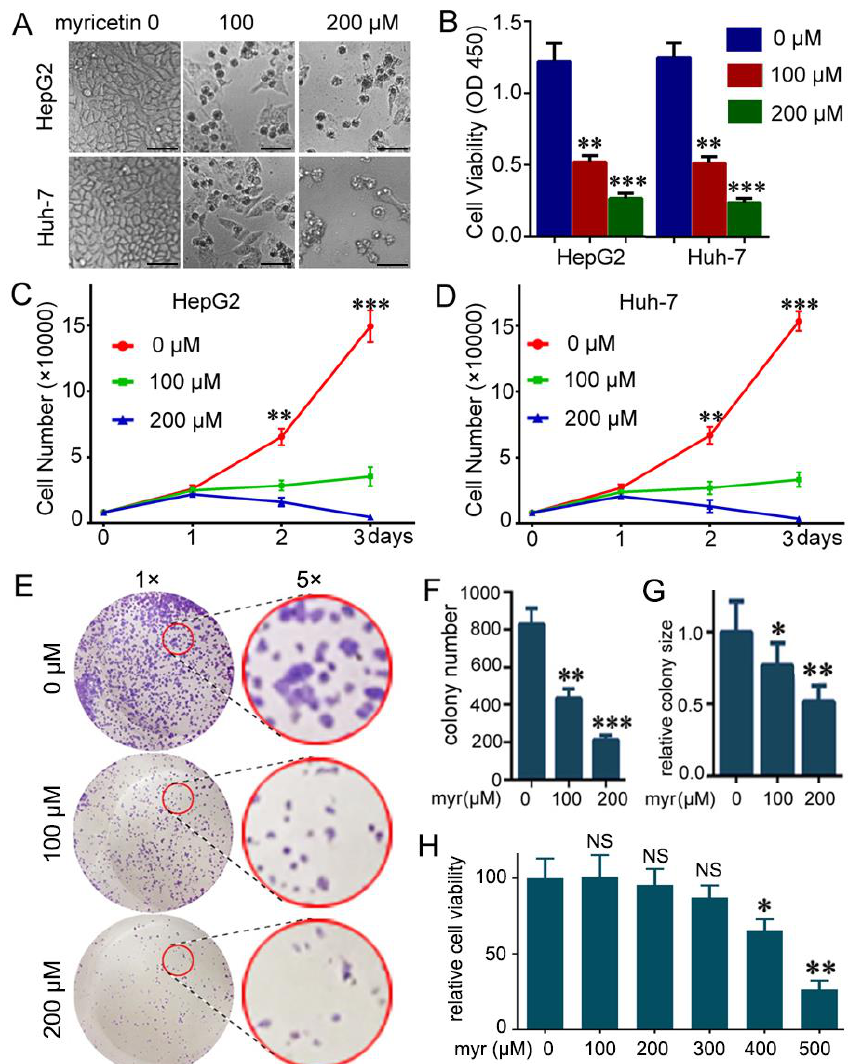
Figure 1. Myricetin suppresses viability of HCC cells. ( A ) Representative images of HCC cells at three days post-treatment with myricetin. Bar, 100 μm. ( B ) HCC cells were treated with the indicated dose of myricetin for 72 h. The cytotoxicity of myricetin was assessed by CCK-8. The absorbance at 450 nm (cell viability) is plotted. Values represent mean ± SD. n = 5, ** p < 0.005; *** p < 0.001, compared to control group. ( C , D ) Cell numbers at indicated days after treatment with myricetin. n = 5, ** p < 0.005, *** p < 0.001, compared to myricetin treated groups. ( E – G ) Huh-7 cells were seeded in 12-well plates (1500/well), and then treated with myricetin for 24 h after growing in the medium without myricetin for 10 days. Colonies were stained and quantified. ( E ) Representative images are shown. ( F ) colony number plotted. n = 3, ** p < 0.005, *** p < 0.001, compared to control group. ( G ) relative colony size was plotted. The colony size in the control group was set as 1. * p < 0.05, ** p < 0.005, compared to control group. ( H ) Normal hepatocyte LO2 cells were treated with the indicated dose of myricetin for 72 h. The cytotoxicity of myricetin was assessed by CCK-8. Relative cell viability was plotted. Values represent mean ± SD. n = 4; NS, not significant; * p < 0.05; ** p < 0.01, compared to control group. To detect the mechanisms underlying myricetin inhibiting cell growth, we compared the proliferation and apoptosis of HCC cells treated with myricetin. EdU-labeling assays showed that